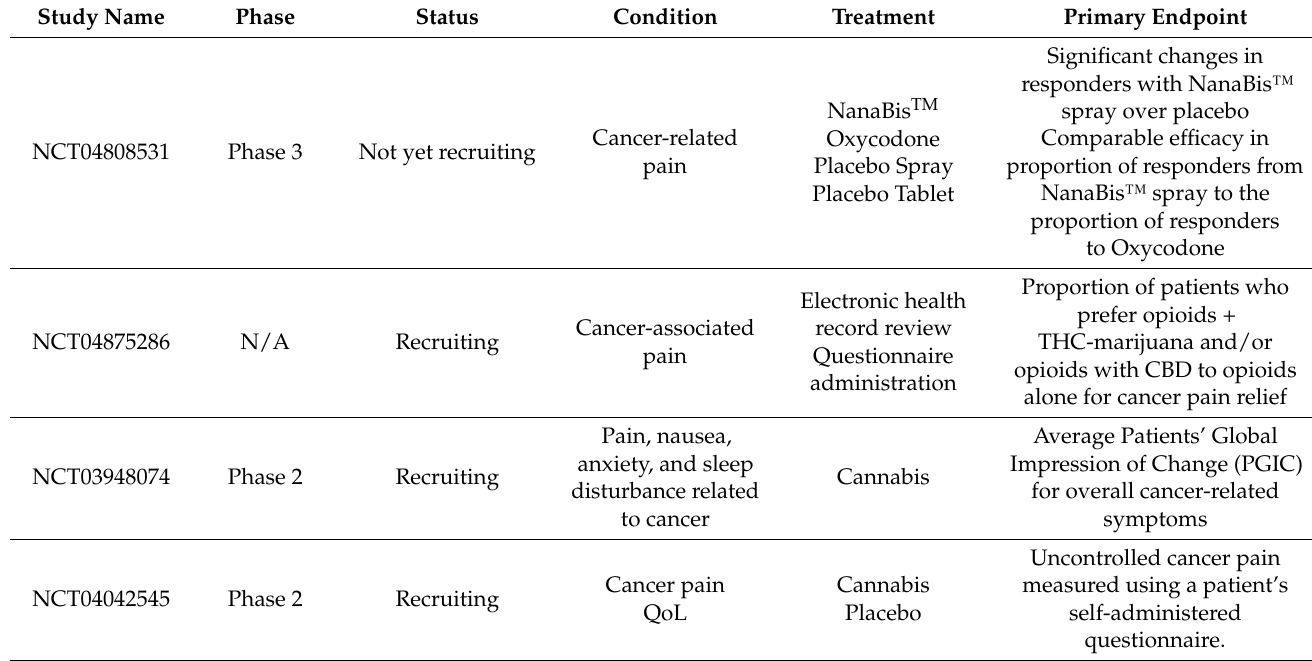
Table 1. Ongoing clinical trials investigating Cannabinoids for cancer